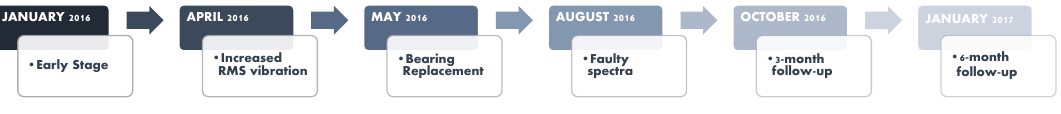
Figure 1. Chronological diagram of the case